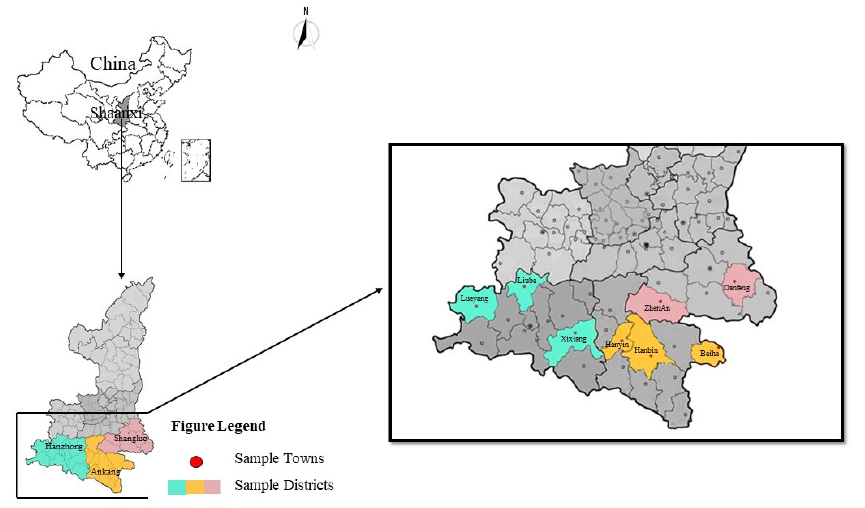
Figure 3. Study location in Shaanxi Province of China.